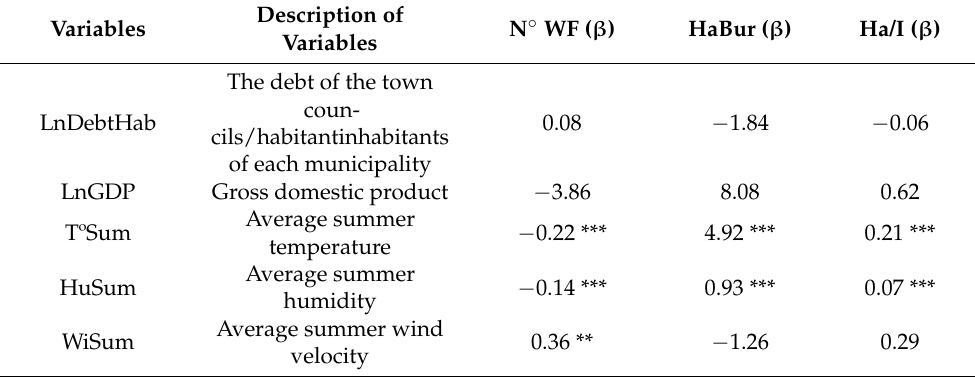
N ◦ WF ( β ) HaBur ( β ) Ha/I ( β ) 0.08 − 1.84 − 0.06